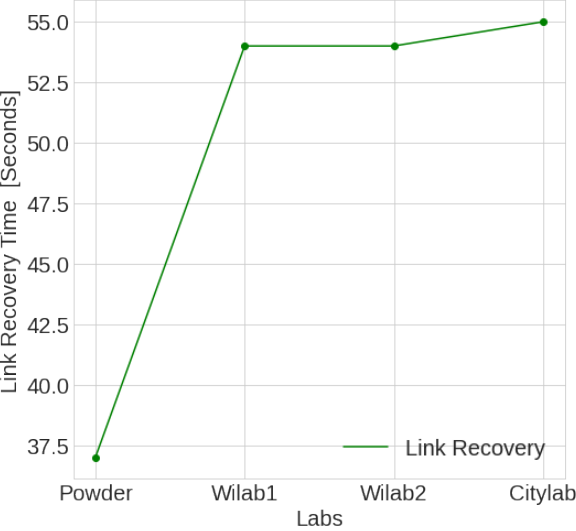
Figure 35. Link failure